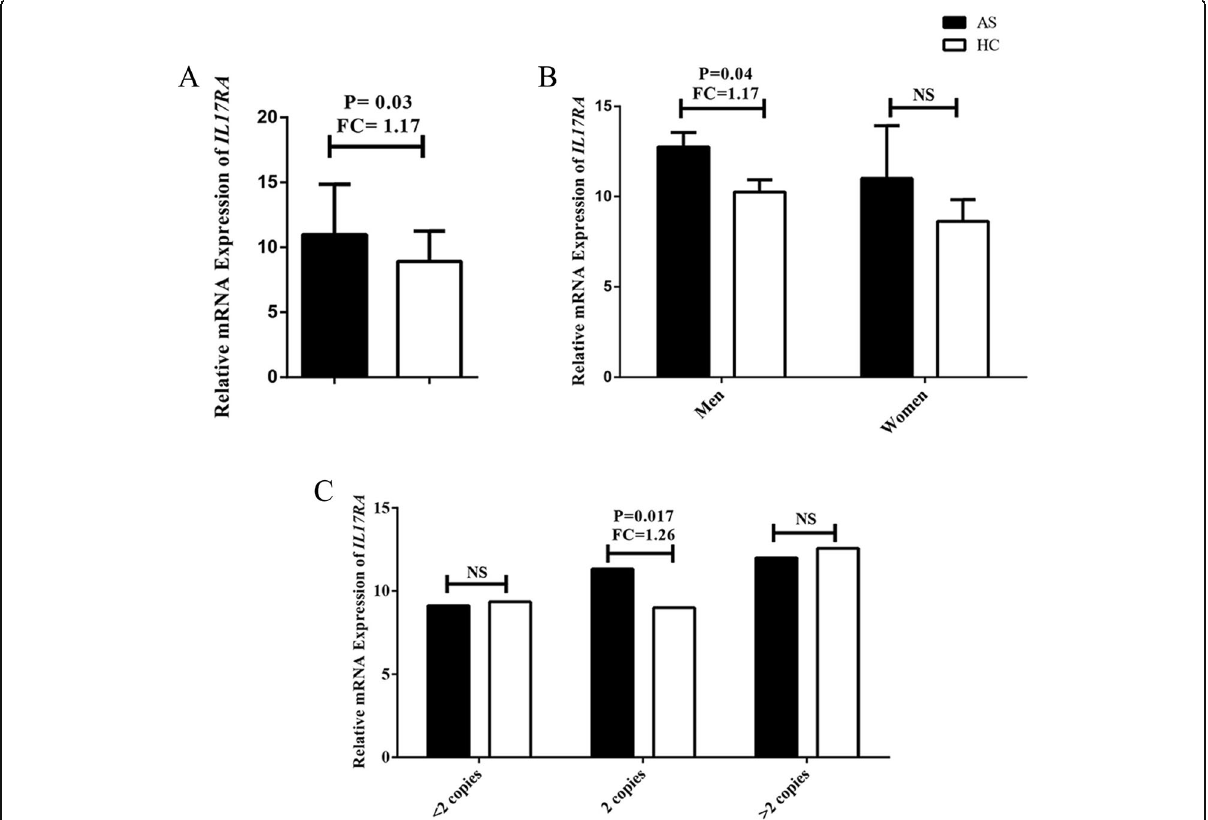
Fig. 2 a Relative gene expression of IL17RA in all AS patients and healthy controls (HC). b Relative gene expression of IL17RA in AS and healthy control